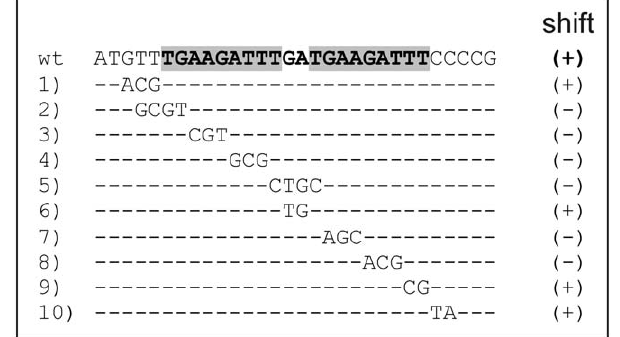
Figure 5. Mutational analysis of the putative CopR binding site within the cg3286- copR intergenic region. To determine the importance of the predicted binding motif (sequence in the grey boxes) for CopR binding, fragments with different mutations were tested in EMSAs with phosphorylated CopR. According to the results of the shifts, the fragments were classified into two categories: + , mutated fragment shifted like the wild type fragment; -, the fragment was not shifted.